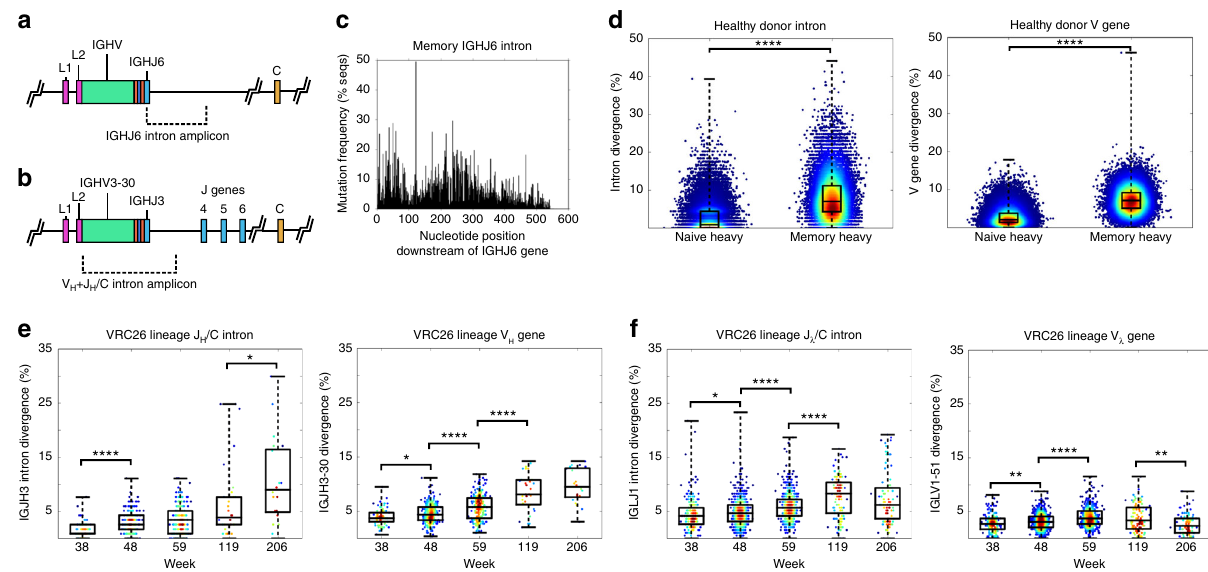
Fig. 1 Exonic and intronic mutations accumulate in healthy donor and VRC26 B cells. a Diagram of a human heavy chain locus with a rearranged IGHJ6 gene and the IGHJ6 intron amplicon source. b A human heavy chain locus with a rearranged IGHJ3 gene with an example V H + J H /C intron amplicon source indicated. All V H + J H /C VRC26 heavy chain amplicons are of the IGHJ3 rearrangement. c The intronic mutation distribution across a ~550 bp segment directly downstream of the J gene of IGHJ6-rearranged antibodies from healthy donor mBCs (number of sequences ( n ) = 4796). d Germline divergence of V H + J H /C sequences from naive B cells and mBCs from a healthy donor. Intron divergence is shown (left) as well as the corresponding V gene divergence (right) (Naive Heavy: n = 47,372, Memory Heavy: n = 19,704). e Intron divergence (left) and V gene divergence (right) for VRC26 heavy chains at all longitudinal time points (week 38: n = 78, week 48: n = 240, week 59: n = 193, week 119: n = 30, week 206: n = 20). f Intron divergence (left) and V gene divergence (right) for VRC26 light chains at vall longitudinal time points (week 38: n = 184, week 48: n = 807, week 59: n = 570, week 119: n = 110, week 206: n = 85). Points are colored by point density using the Python Gaussian kernel density estimator function for visualization. Two-tailed Mann – Whitney U test p -values are shown (**** p -value ≤ 0.0001, *** p -value ≤ 0.001, ** p -value ≤ 0.01, * p -value ≤ 0.05). Center lines on boxplots represent the median, while the box limits represent the upper and lower quartiles and whiskers show the maximum and minimum values